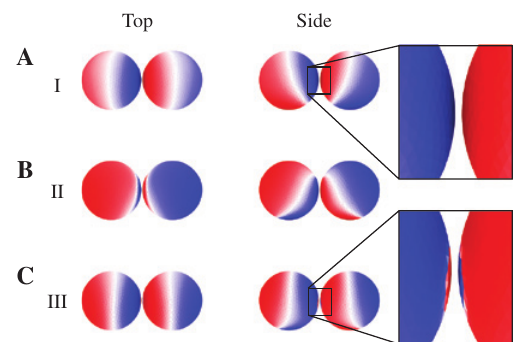
Figure 6: Logarithmic plots of the simulated surface charge density distributions of a spherical gold dimer with diameters of 90 nm and a gap width of 2 nm on a silicon substrate with 1 nm of silicon oxide calculated at the peak wavelengths found in Figure 5.